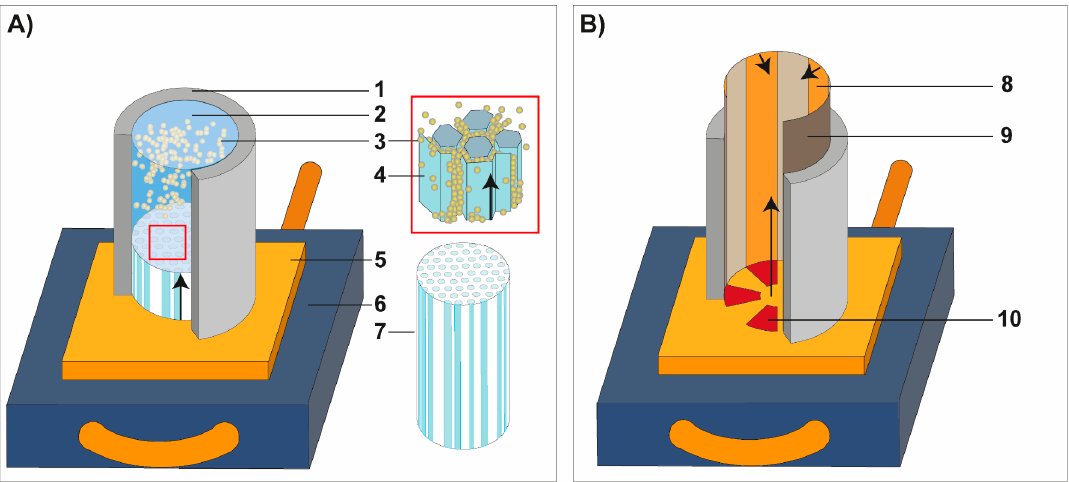
Figure 3. Schematic illustration of the mold designs for the freeze-casting process. ( A ) The conventional setup for producing unidirectional pore systems consists of a polytetrafluorethylene (PTFE) tube that was fixed on a copper plate. The mold design in ( B ) was used to manufacture a structural graded ceramic inspired by the microstructure of spine of Phyllacanthus imperialis . The freezing direction is indicated by the black arrows. 1: PTFE-mold, 2: particle suspension, 3: Al 2 O 3 particle, 4: ice crystal, 5: copper plate, 6: cold plate, 7: frozen suspension with unidirectional ice crystals, 8: copper film, 9: Teflon film, 10: silicon film.